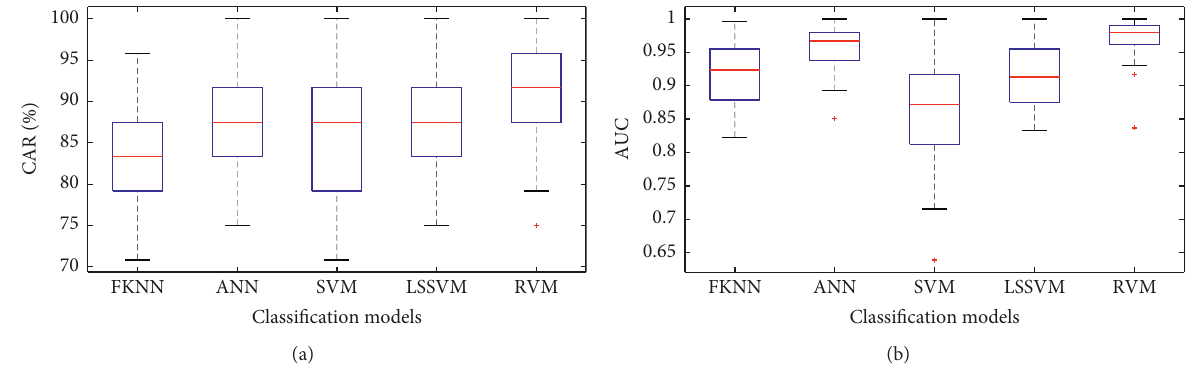
Figure 5: Performance of soil erosion prediction models: (a) CAR and (b) AUC.